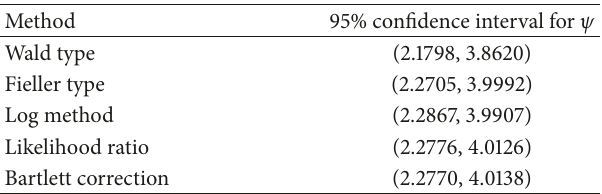
Table1:95%confidenceintervalfor 𝜓 fortheexperimentbyFaupel- Badger et al.